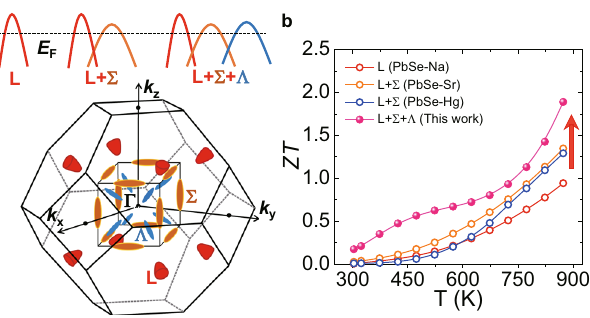
Fig. 1 Multiple valence bands enable high ZT values in p-type PbSe. a Schmatic diagram of multi-bands (L, Σ , Ʌ ) involvement in transport. The Brillouin zone shows that the degeneracies at the L, Σ , and Ʌ points are 4, 12, and 8, respectively. b The activated third band Ʌ enables higher ZT values compared with the single-band and two-band PbSe-based